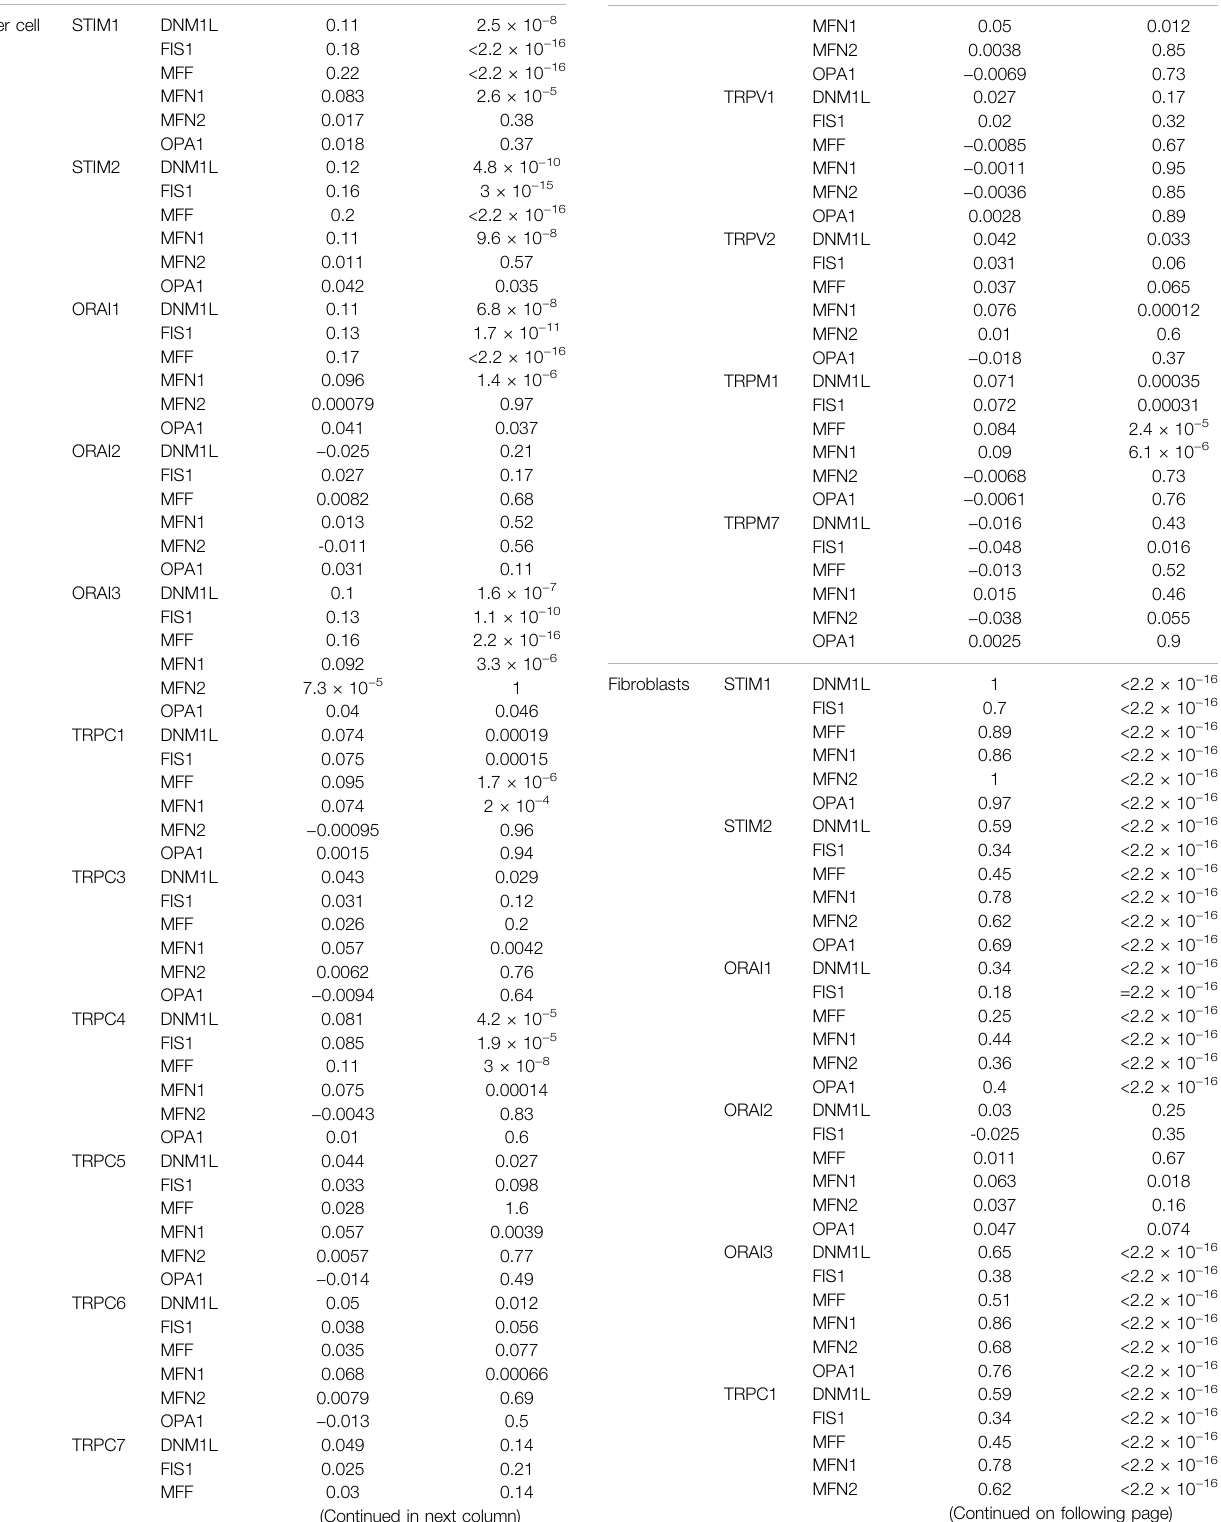
TABLE 1 | ( Continued ) The correlation coef fi cient and p -value for SOCs and MDGs in cancer cells and fi